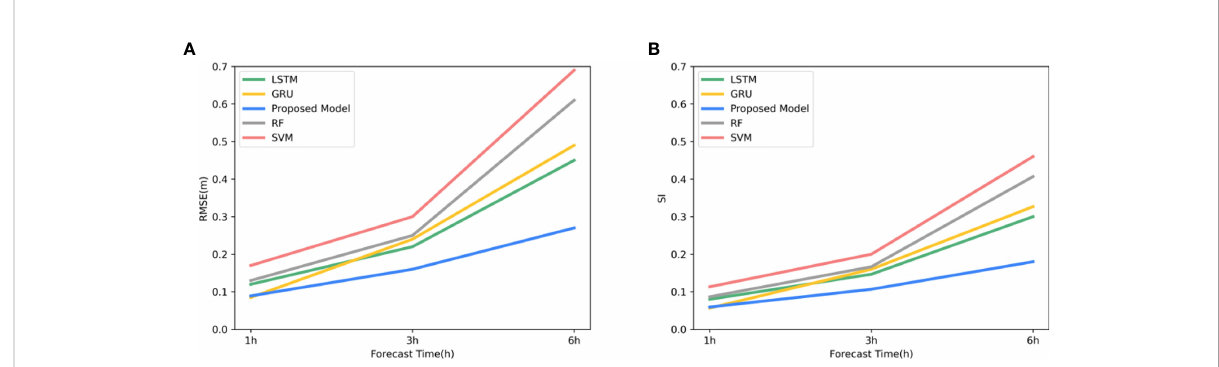
FIGURE 7 The difference in prediction effect of different algorithms: (A) RMSE of different algorithms varies with the forecast time, and (B) SI of different algorithms varies with the forecast